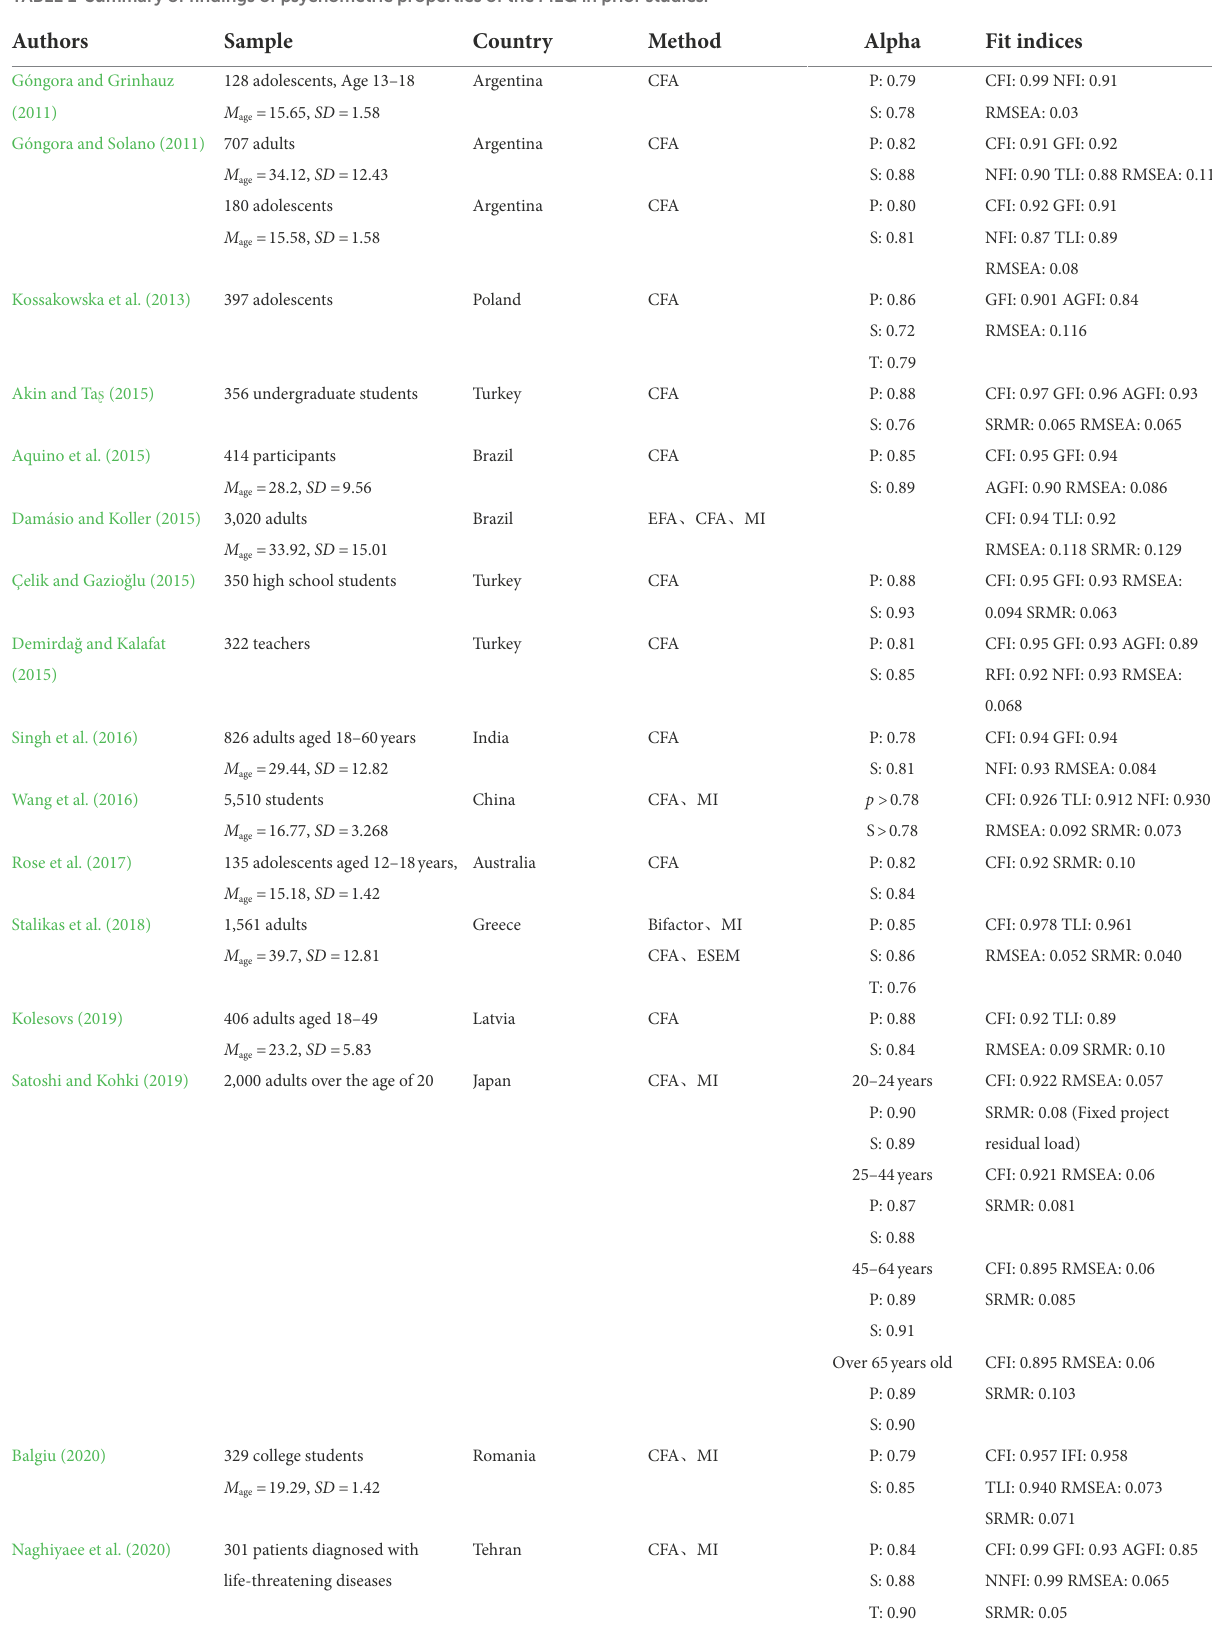
TABLE 1 Summary of findings of psychometric properties of the MLQ in prior